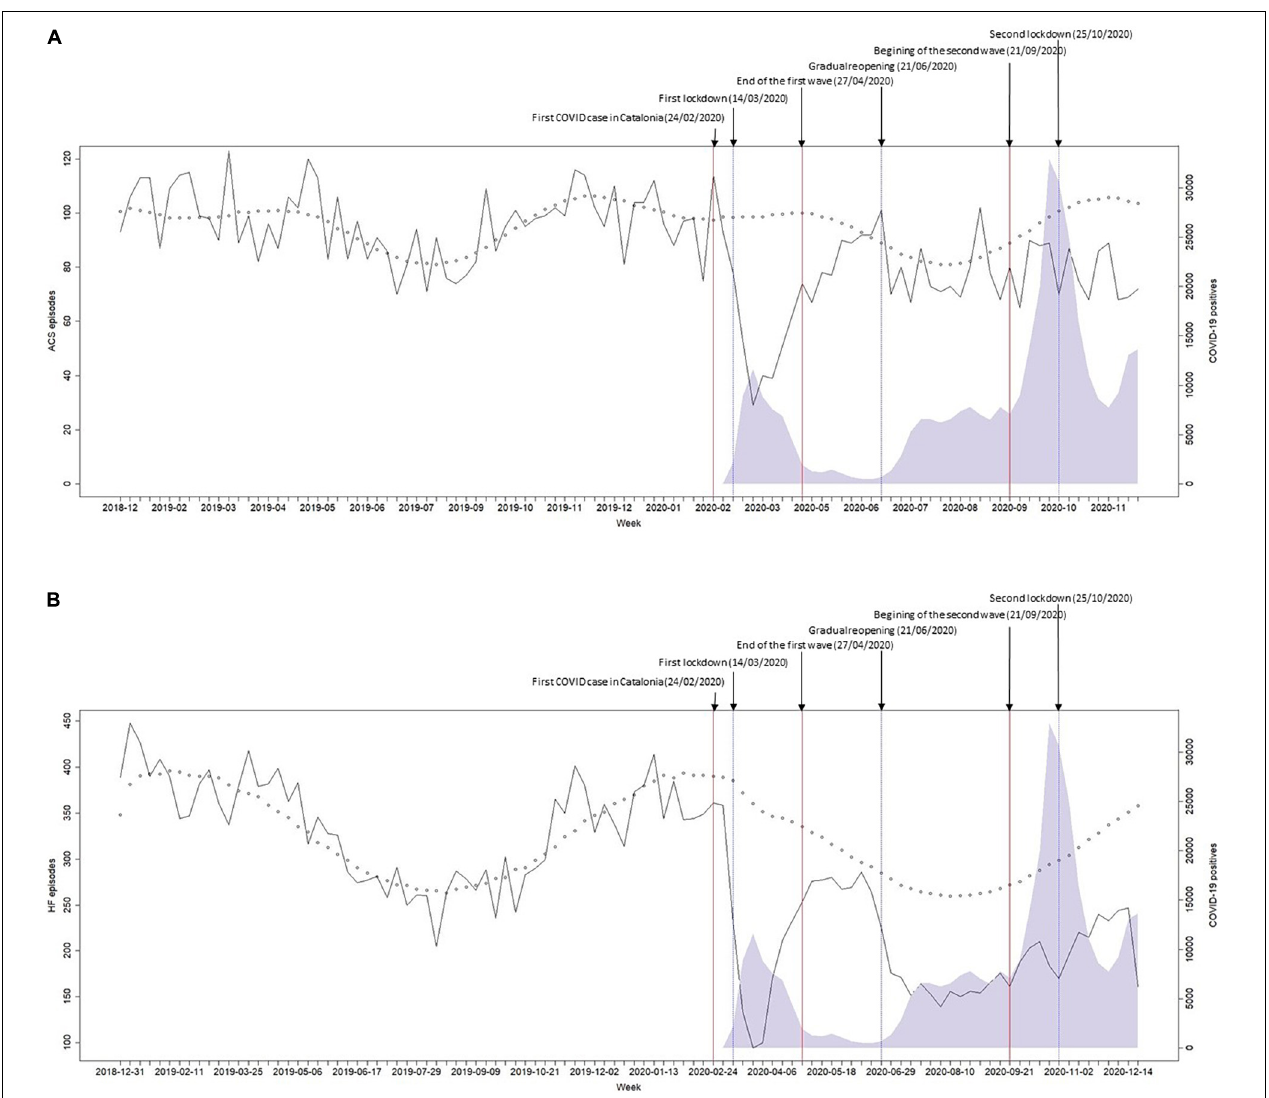
FIGURE 2 | Weekly number of hospital admissions for (A) acute coronary syndrome and (B) heart failure, between 31 December 2018 and 27 December 2020. Black line: observed hospital admissions; shaded area: number of COVID-19 cases; red lines: predefined period limits: pre-pandemic, first wave, period between waves, and second wave; small circles: negative binomial model estimated values